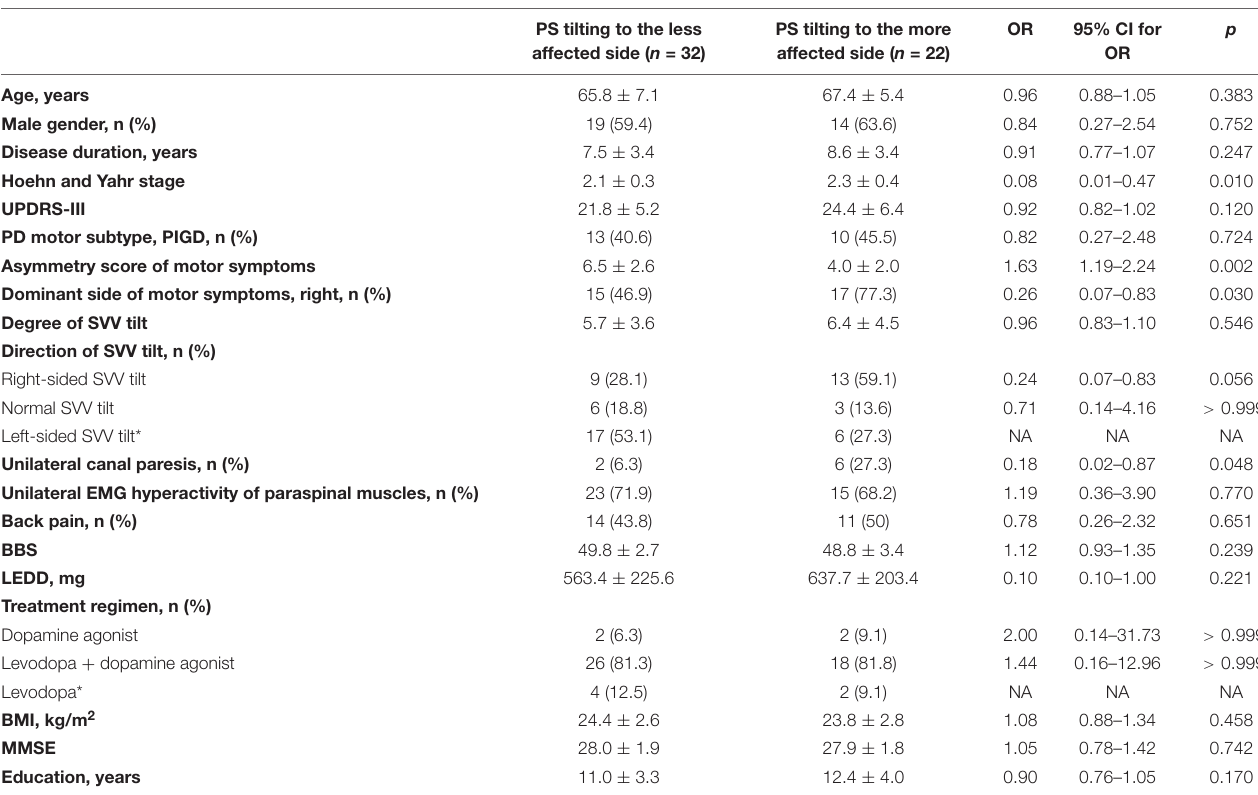
TABLE 2 | Univariable analysis of clinical factors associated with PS tilting to the less affected side.